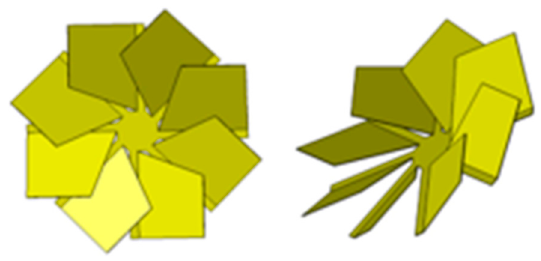
Figure 2. Standard urea mixer design.